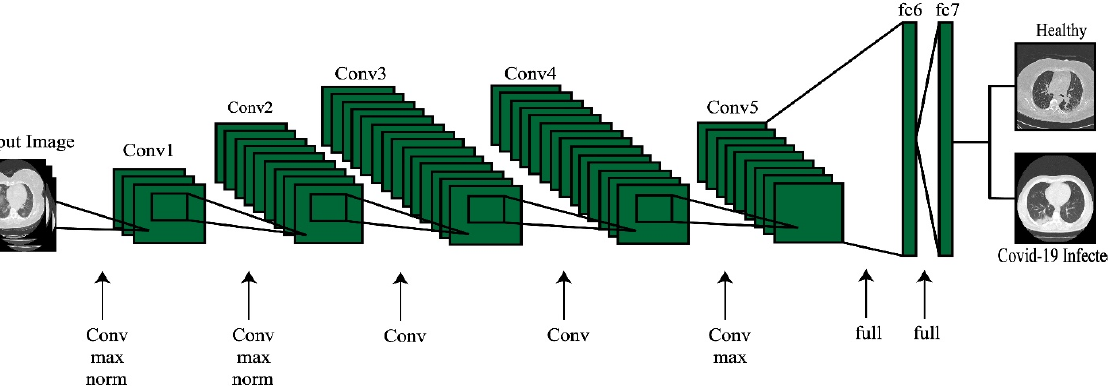
Figure 4. Fine-tuned AlexNet pre-trained model for healthy vs. COVID-19-infected classification.